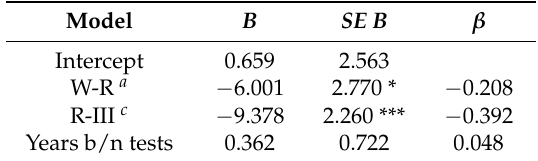
Table 3. Multiple regression analyses predicted D-score with R-R as baseline group.